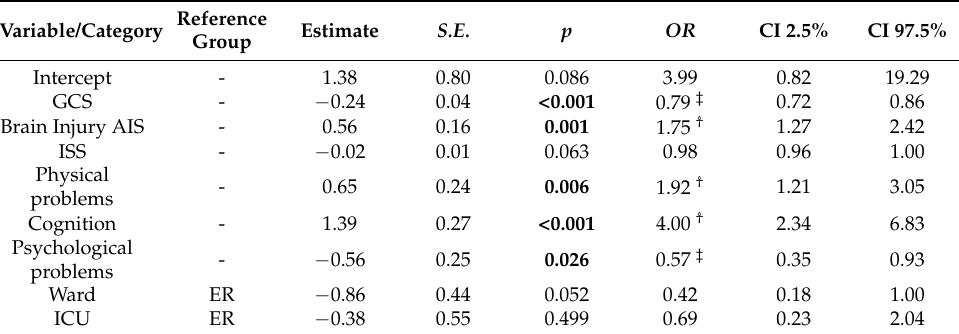
Table 6. Results of the logistic regression (final